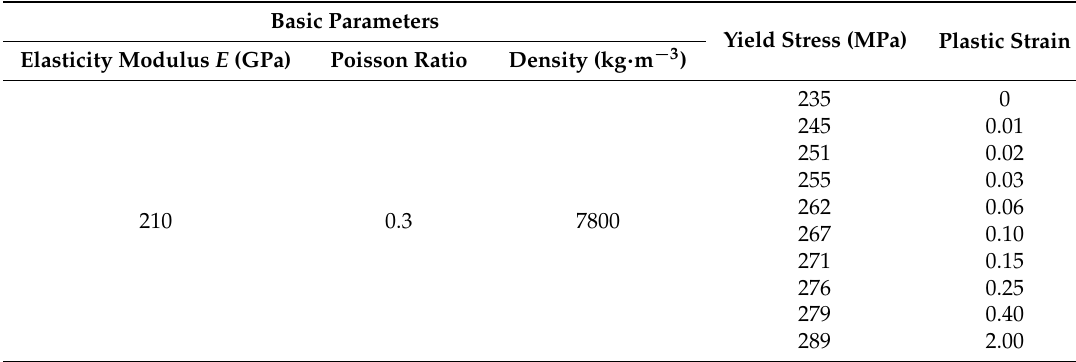
Table 8. Mechanical properties of marine steel Q235.